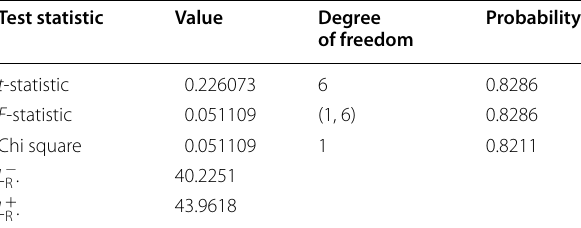
Table 3 Nonlinear autoregressive distributed lag (NARDL) model Source : Author’s computation based on e-views